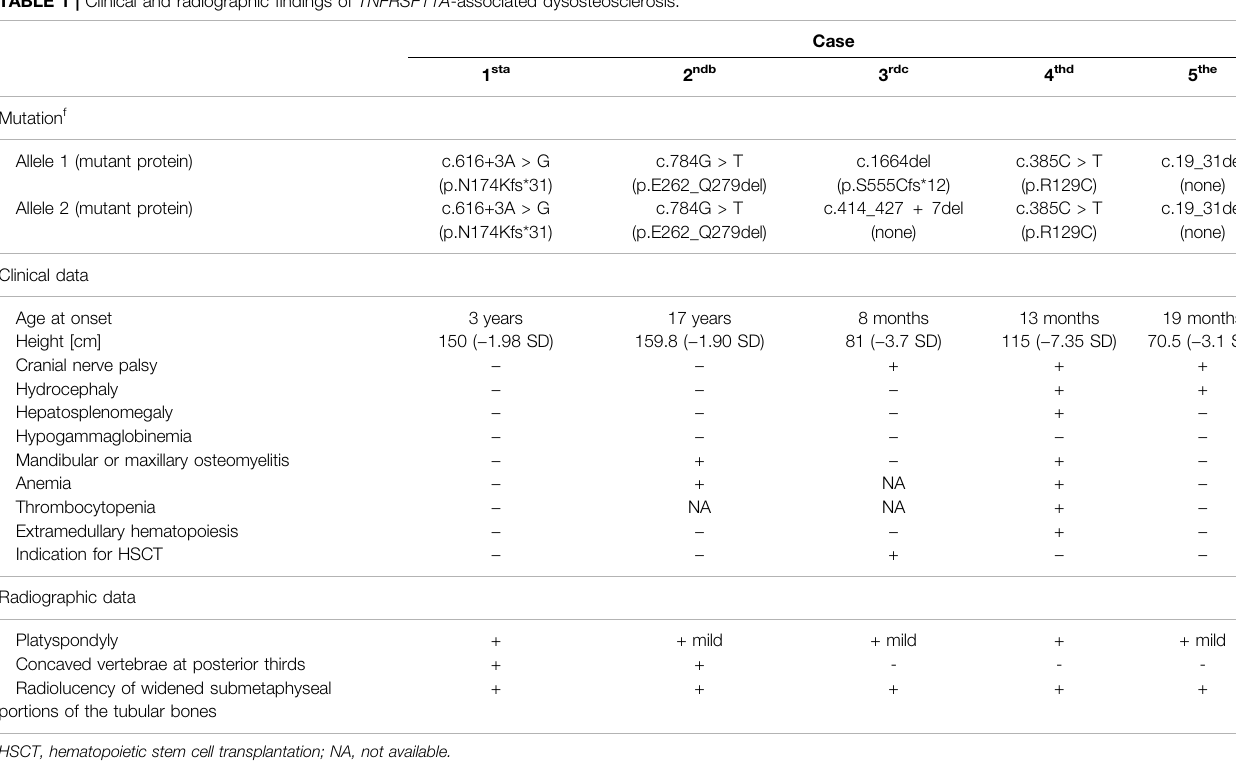
TABLE 1 | Clinical and radiographic fi ndings of TNFRSF11A -associated dysosteosclerosis.